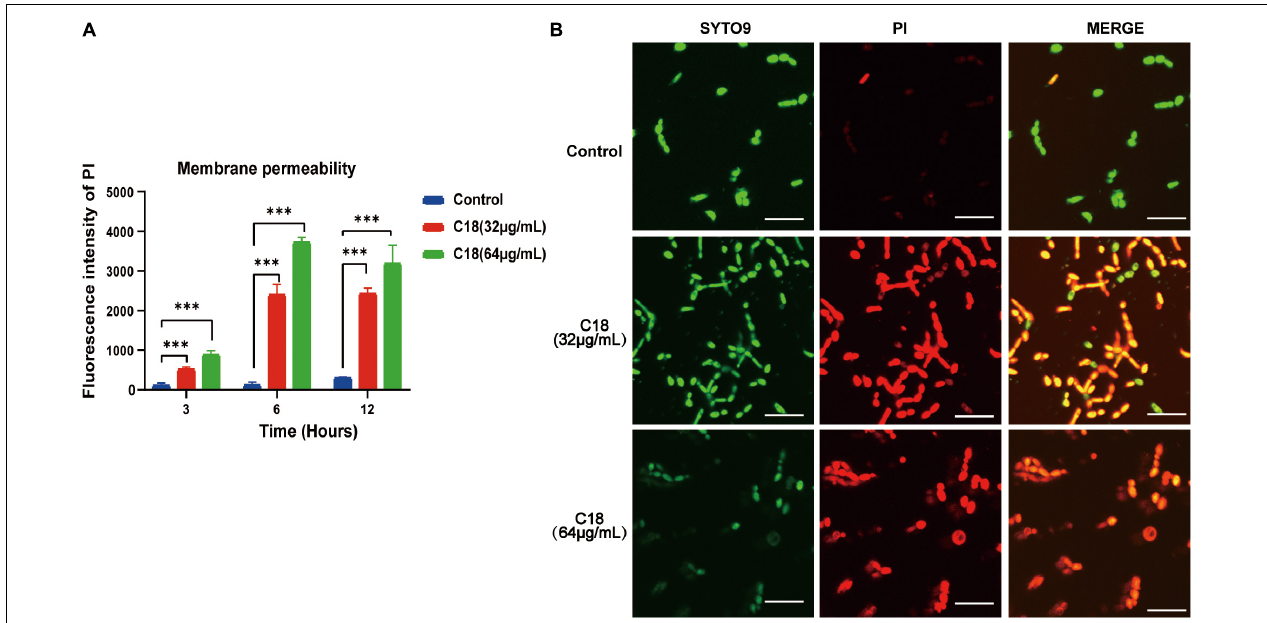
FIGURE 6 | Effect of C18 on the cell membrane permeability of Candida albicans . (A) Fluorescence intensity of propidium iodide (PI) (10 µ g/ml) after C18 treatment was detected by sectrofluoro-photometer. Error bars represent standard deviation of three independent experiments. ∗∗∗ p < 0.001 compared to the control group. (B) Fluorescence images of C. albicans cells stained by SYTO9 (10 µ M) and PI (10 µ g/ml) after C18 treatment for 6 h using confocal laser scanning microscopy (CLSM). Green represents live microbes while red represents dead microbes, and the merge shown in both green and red are combined from the two channel images. Scale bar 20 µ